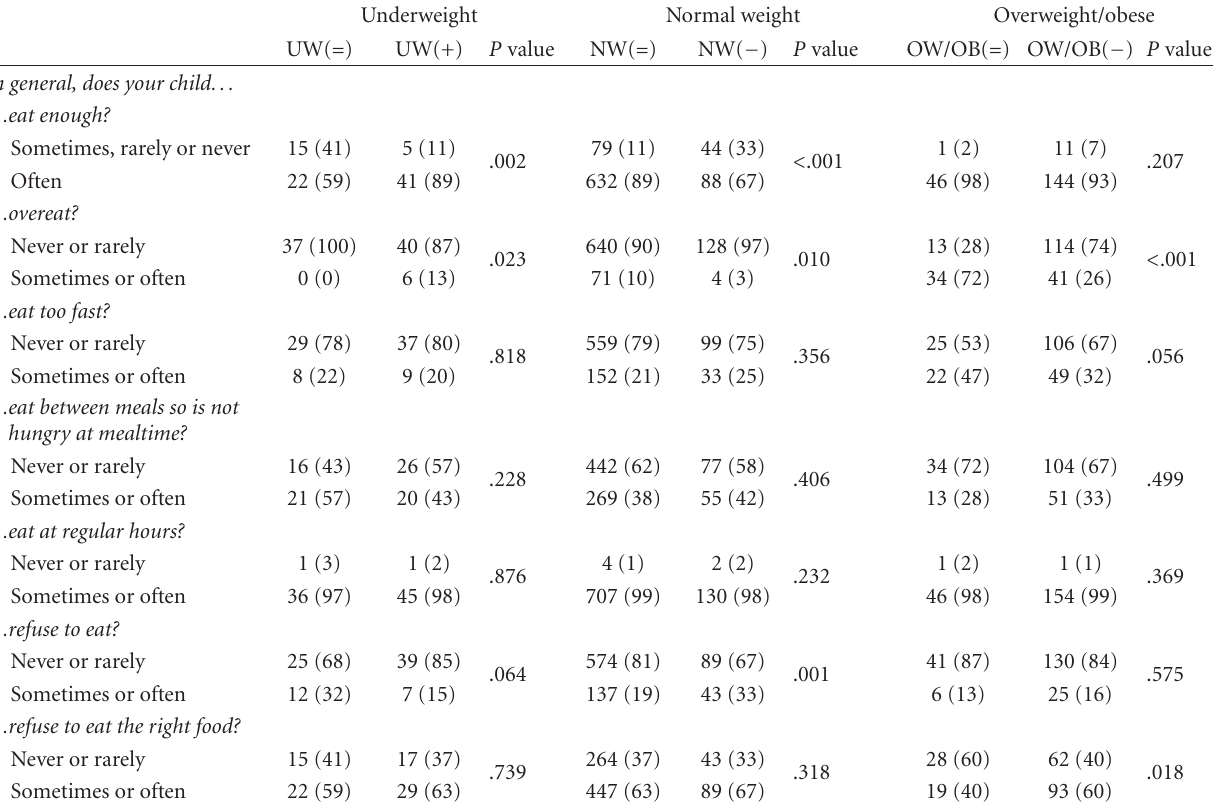
Table 2: Comparison of eating habits of children within a given body weight group perceived accurately or not. Underweight Normal